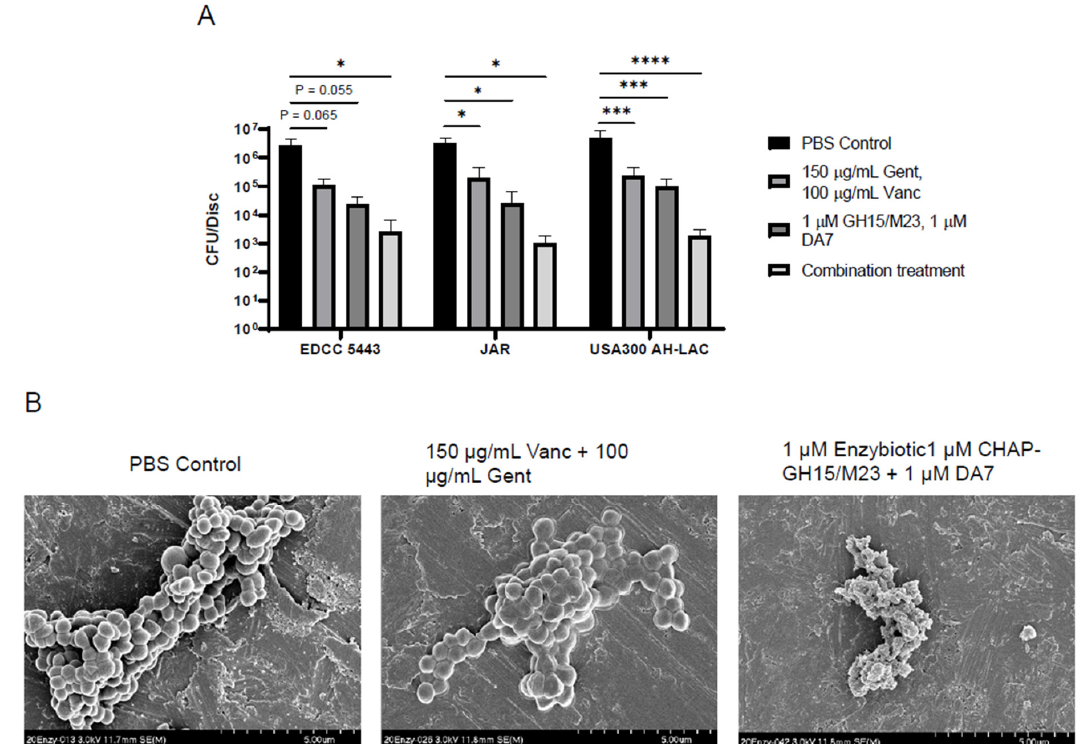
Figure 3. Enzybiotics and classical antimicrobial chemotherapy together enhance biofilm clearance in a titanium device biofilm model. ( A ) CFU counts recovered from biofilm of the three indicated S. aureus strains were grown on titanium discs, treated with enzybiotics, antibiotics. Combination treatment indicates a full treatment with 150 µg/mL Gent, 100 µg/mL Vanc, 1 µM equimolar GH15/M23/DA7. CFU counts recovered per disc are reported ( n > 3). ( B ) Scanning electron microscopy (SEM) of treated biofilms grown on titanium discs. Scale bars are indicated at the bottom right of each image. **** p ≤ 0.0001, *** p ≤ 0.001, * p ≤ 0.05, ns: p > 0.05.